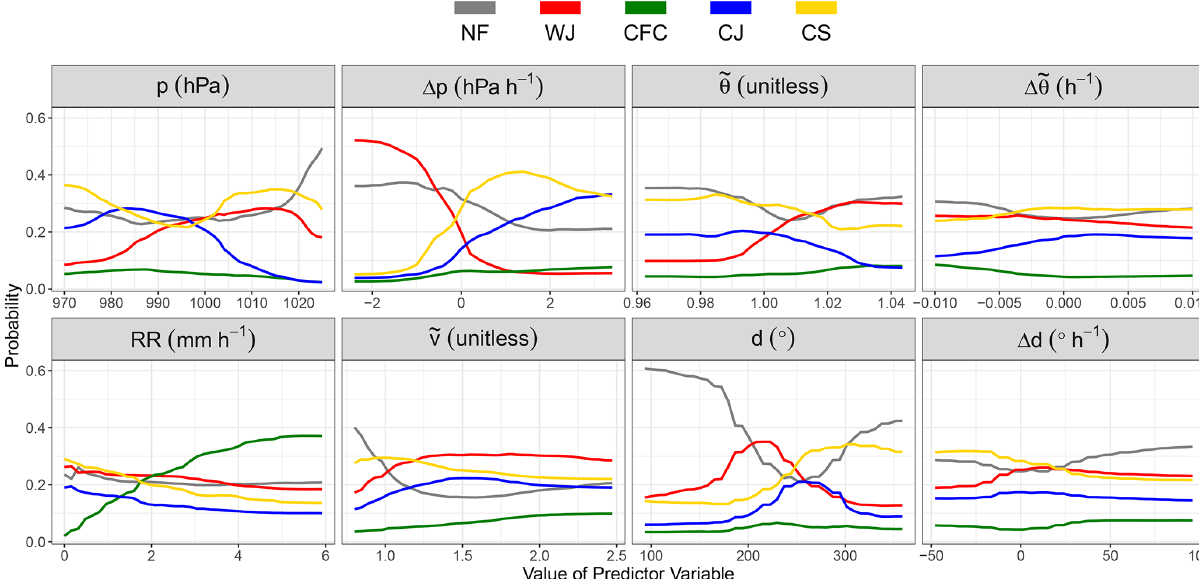
Figure 10. Partial dependence plots for the predictor variables and wind